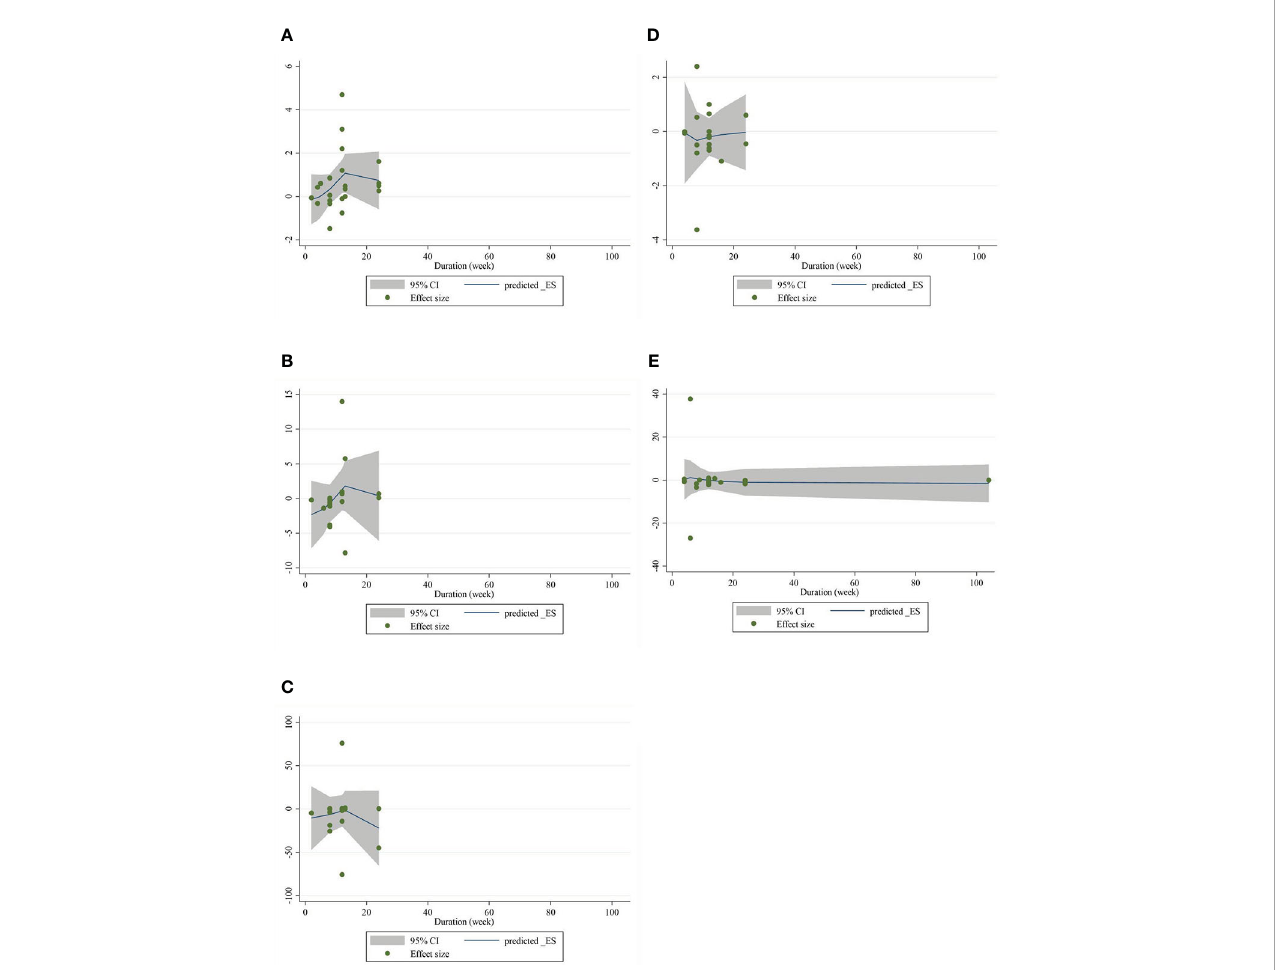
FIGURE 5 Nonlinear dose – response analysis on the effects of the duration of the intervention (week) of CLA on (A) CRP (mg/L), (B) IL-6 (pg/ml), (C) TNF- a (ng/ml), (D) adiponectin (µg/ml), and (E) leptin (ng/ml). Horizontal lines represent 95% CIs. Diamonds represent pooled estimates from random-effects analysis. WMD, weighted mean difference; CI, con fi dence interval; CLA, conjugated linoleic acid; CRP, C-reactive protein; IL-6, interleukin 6; TNF- a , tumor necrosis